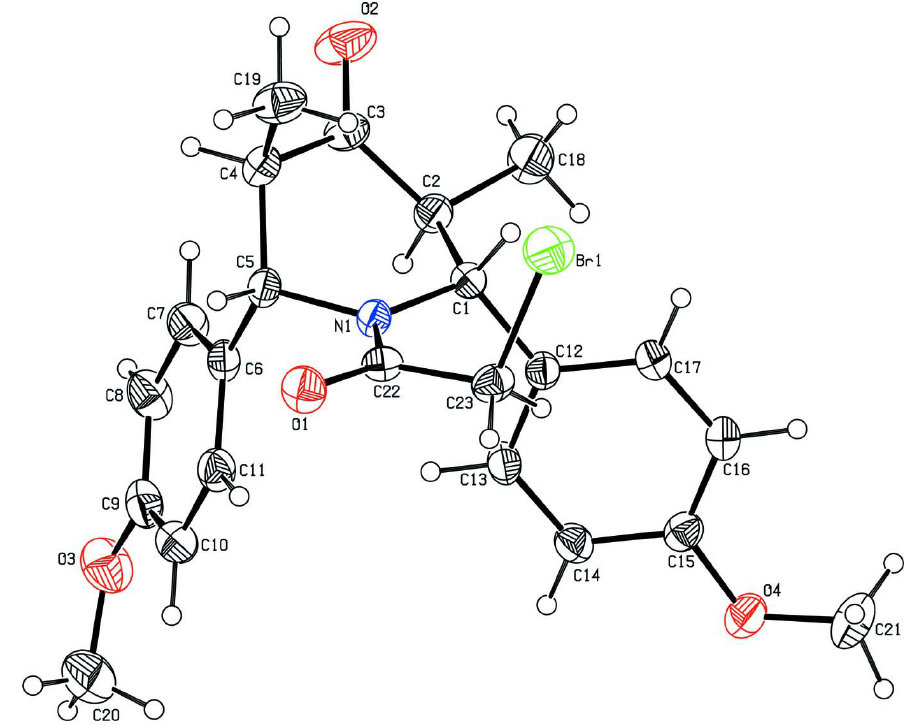
The molecular structure of title compound, showing 30% probability displacement